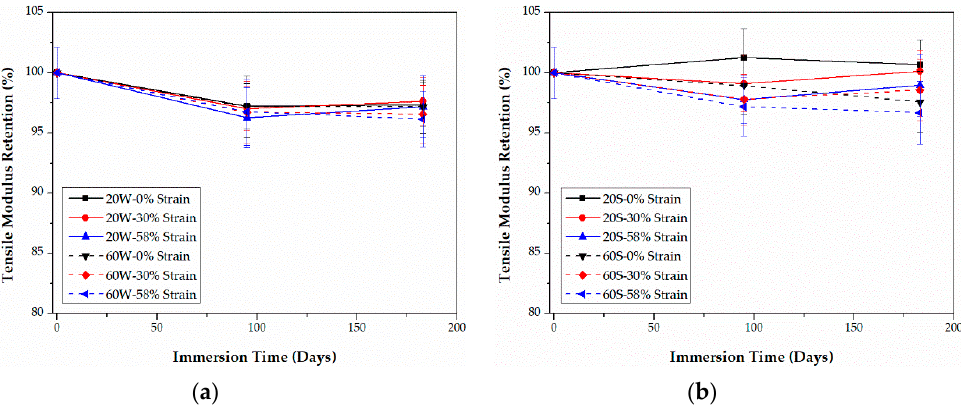
Figure 11. Retention of the tensile modulus of epoxy-based CFRPs immersed in distilled water ( a ) and seawater ( b ) for 6 months, respectively.